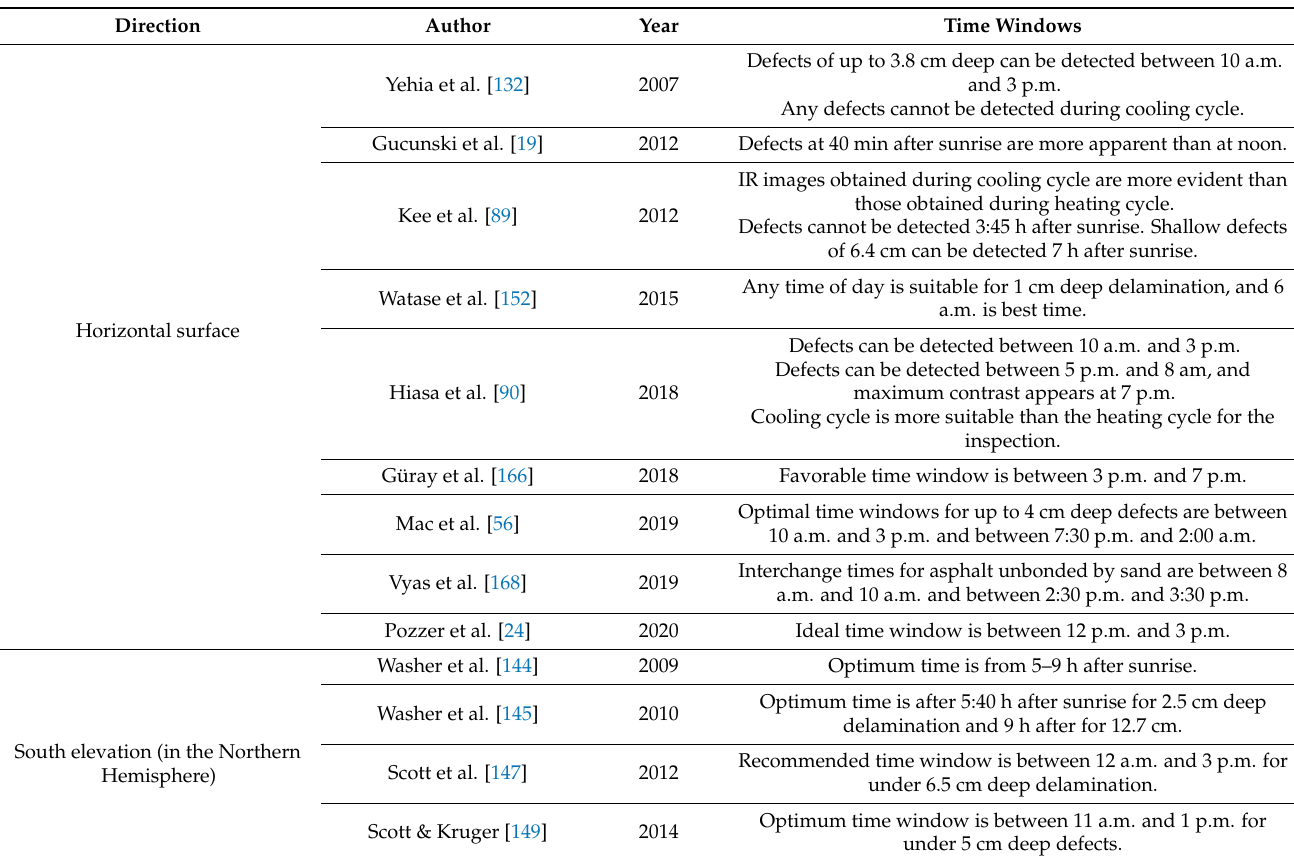
Table 3. Suitable time windows and interchange times proposed by previous